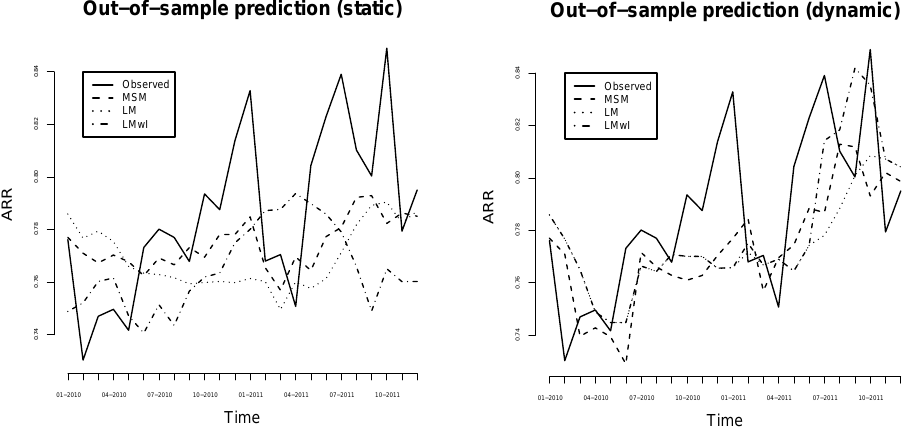
Figure 21. Out-of-sample prediction of the linear model (LM), the linear model with intersecations (LMwI) and the Markov switsching model (MSM) for static models ( left ) and the dynamic models ( right ). The observed ARR is displayed in the solid